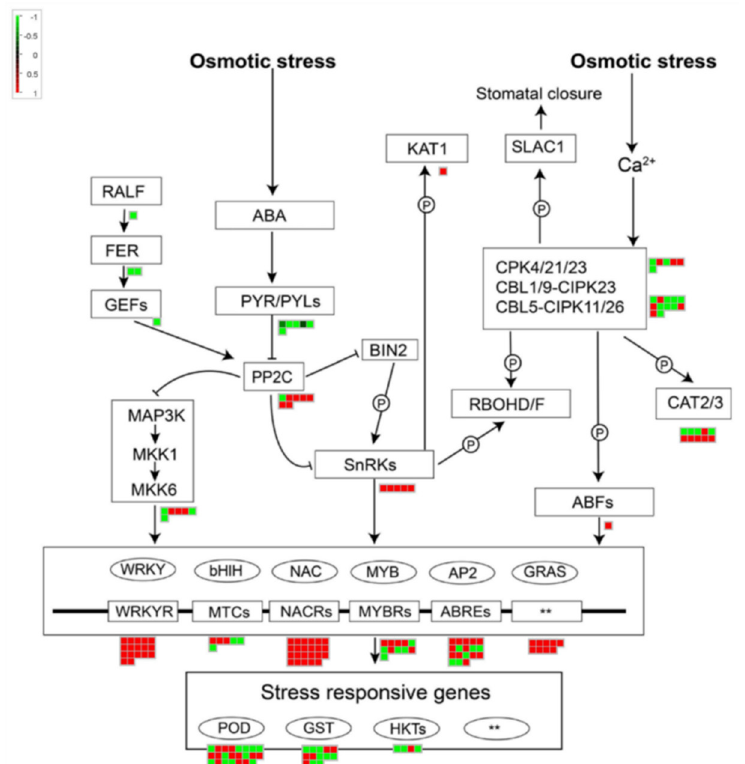
Figure 5. Genes involved in response to salt and drought stress in I. lactea var. chinensis transcriptomes. Relative expression profiles were showed in green-black-red scale, red indicates log 2 (fold change) > 0, green indicates log 2 (fold change) < 0. ABA, abscisic acid; PYR/PYLs, pyrabactin resistance 1-like protein; PP2C, type 2C protein phosphatases; SnRKs, Snf1 (sucrose non-fermenting-1)-related